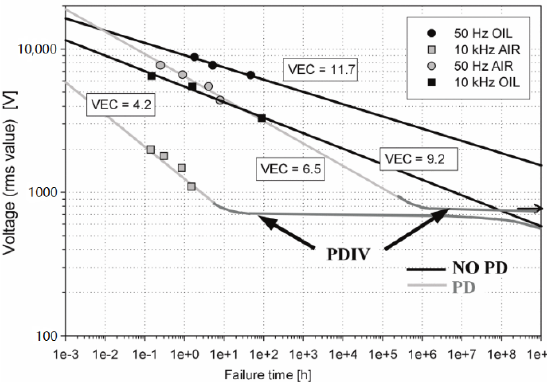
Figure 6. Electrical aging in the presence (air) and absence (oil) of PD.